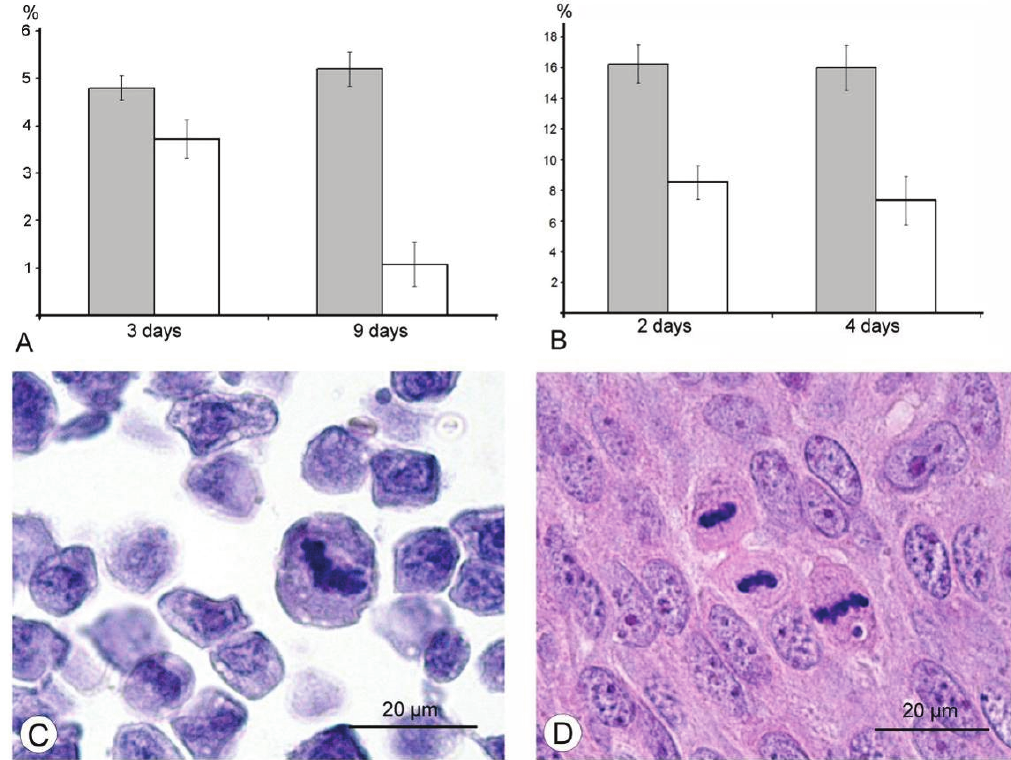
Figure 6. Decrease in number of mitoses in murine Ehrlich ascitic carcinoma ( A ) and human A431 carcinoma xenografts ( B ) after injection of the L-IVP strain. The period after virus injection is shown on the X-axis; the percent of mitotic cells in shown on the Y-axis. The white columns correspond to the L-IVP treated mice, the grey columns correspond to saline treated. Counting was performed on paraffin sections at 400-fold magnification. Photos ( C ) and ( D ) show mitotic cells in paraffin section of Ehrlich ascitic and A431 carcinomas, respectively.